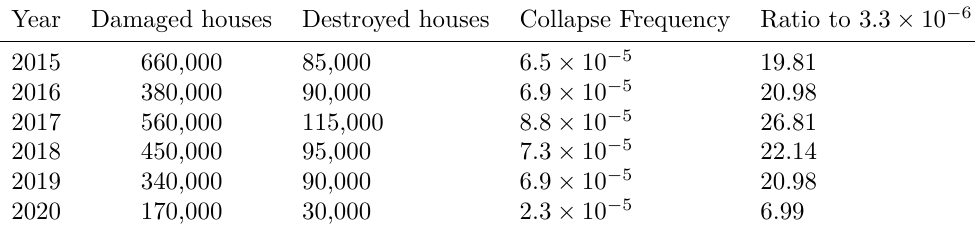
Table 3. Number of damaged and destroyed houses during earthquakes per year worldwide (Earthquake Impact Database). The total stock of buildings has been assumed with 1.3 billion, which is slightly below 1.5 used in [38].